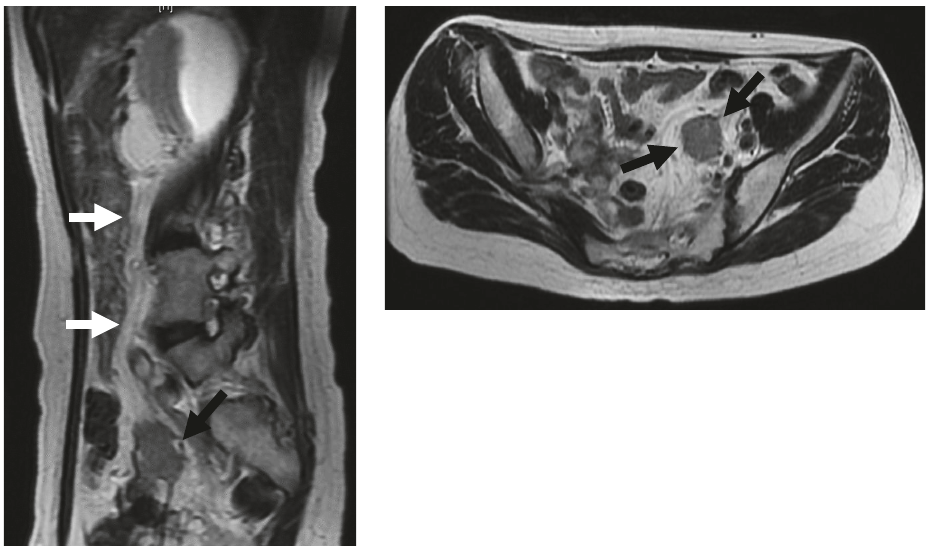
Figure 1: MRI findings of (a) the abdomen and (b) the pelvis with T2-weighted images: white arrows: left ureter and black arrows: a postperitoneal tumor.